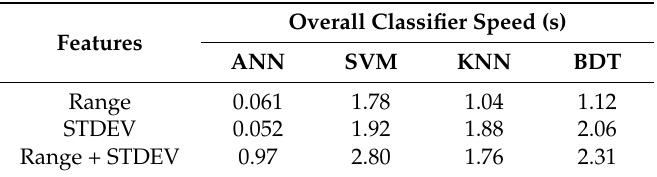
Table 8. Summary of each classifier’s speed when different input features are